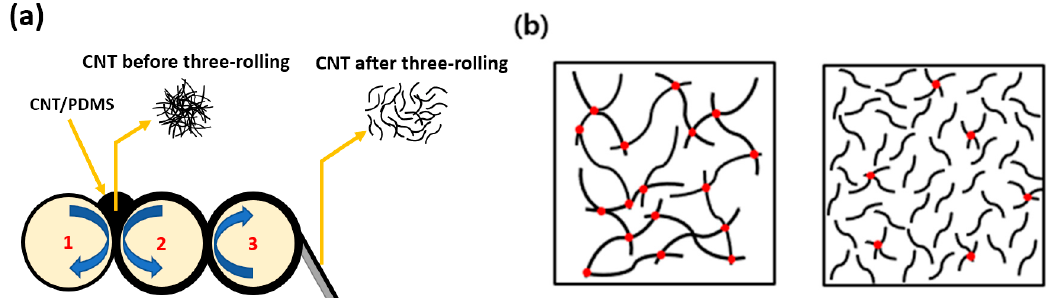
Figure 1. A scheme of ( a ) a carbon nanotube (CNT) dispersion mechanism during three-roll milling. ( b ) Morphology of long CNT composite (left) and short CNT composite (right) with the same filler content. Red dots indicate the electrical contact points.